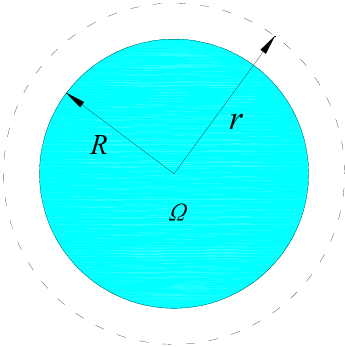
Figure 3. Discretization of the axial compression on the part boundary of the circular shaft.